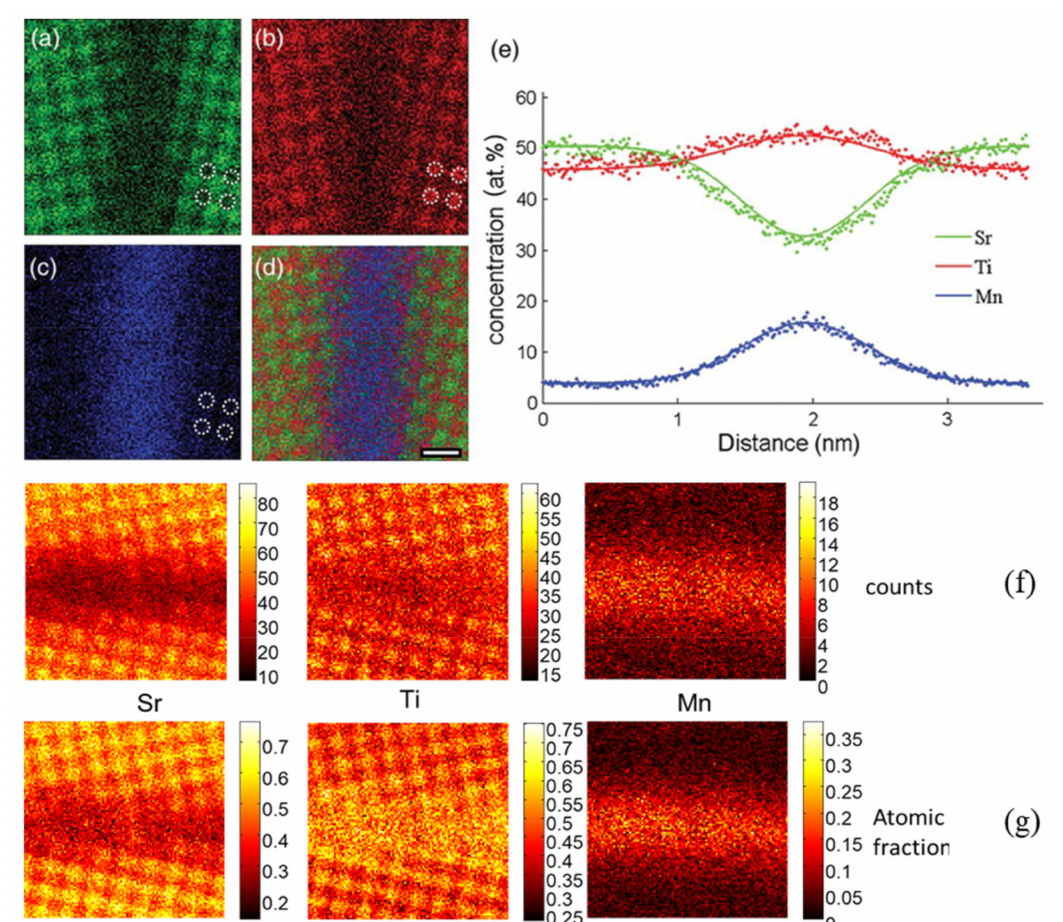
Figure 31. Atomic resolution mapping of the Mn-doped SrTiO 3 GB. EELS compositional maps of ( a ) Sr, ( b ) Ti, ( c ) Mn, and ( d ) composite maps were obtained from the MSA with RGB false colors applied. The scale bar is 0.5 nm. A few nm away from the GB core, Mn has a much lower but detectable concentration, and substitutes the Ti site as indicated by the coincident dashed circles in ( b , c ). The relative concentration profile (at%) across the GB in ( e ) is obtained by concerting the vertically summed up EELS signal of the two-dimensional map using the Cliff–Lorimer factors of a 200 kV microscope. Atomic EDXS mapping of the Mn-doped SrTiO 3 GB. ( f ) shows count maps of Sr, Ti and Mn, respectively. ( g ) shows the atomic fraction of elements normalized to1 (or 100%) using the Cliff-Lorimer factors. As seen clearly in these maps, Ti shows reduced counts but increased concentration (or atomic fraction) as the concentration of Sr drops inside the GB. Reprinted from [224] under the terms of the Creative Commons CC BY